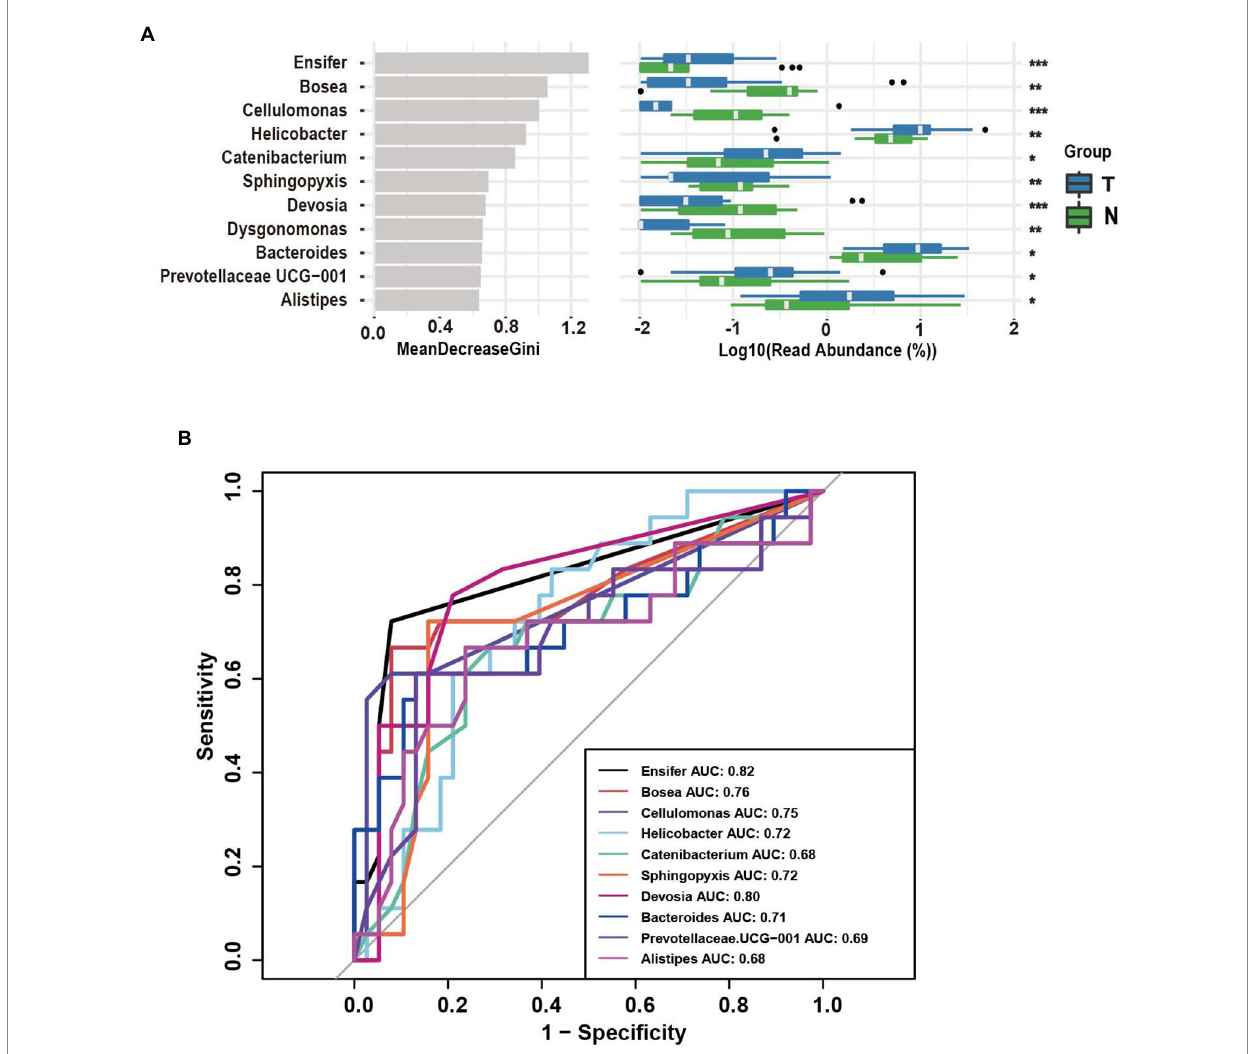
FIGURE 4 Operational taxonomic unit (OTUs)-based markers on vaginal swabs of the embryo-arrest and normal pregnancy groups. (A) Random forest algorithm of the vaginal microbiota in the two groups. (B) Receiver operating characteristic (ROC) curve for the prediction of embryo-arrest. T, embryo-arrest group; N, normal pregnancy